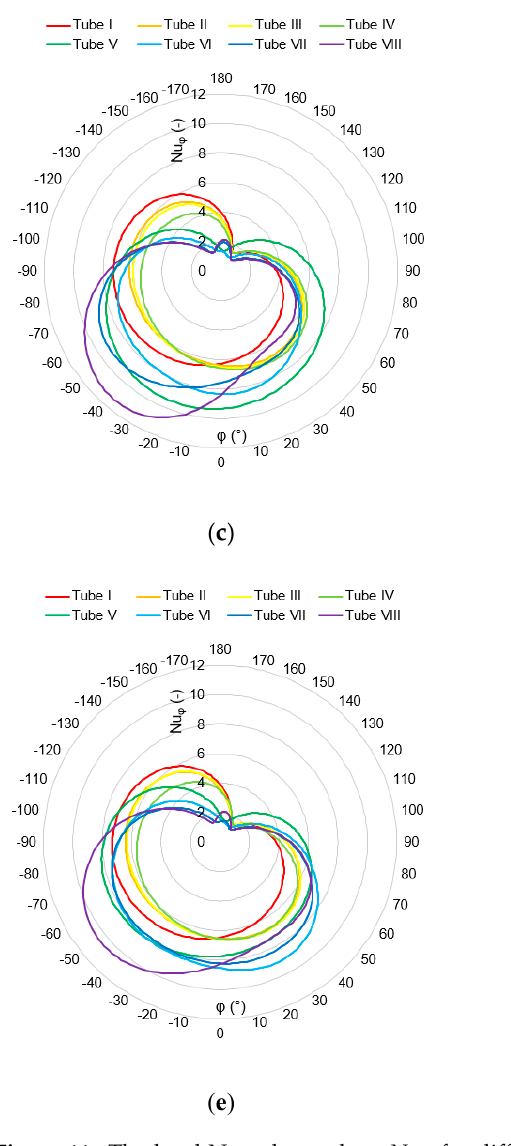
Figure 11. The local Nusselt numbers Nu φ for different configurations of the tube array 4×4 with the tube ratio spacing S/D of 2.5: ( a ) base configuration at Ra = 1.3 × 10 4 ; ( b ) base configuration at Ra = 3.7 × 10 4 ; ( c ) concave configuration at Ra = 1.3 × 10 4 ; ( d ) concave configuration at Ra = 3.7 × 10 4 ; ( e ) convex configuration at Ra = 1.3 × 10 4 ; ( f ) convex configuration at Ra = 3.7 × 10 4 .